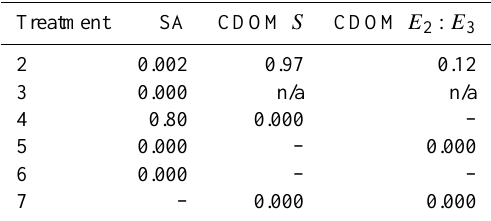
Table 4. Statistical evaluation of no effect of treatment ( p value). Each treatment as detailed in Table 1 was separately tested against “No treatment”. For p < 0 . 05 the treatment is considered to be sig- nificantly different from “No